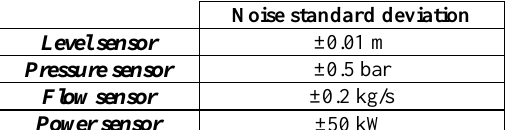
Table 2. Standard deviation of sensors noise